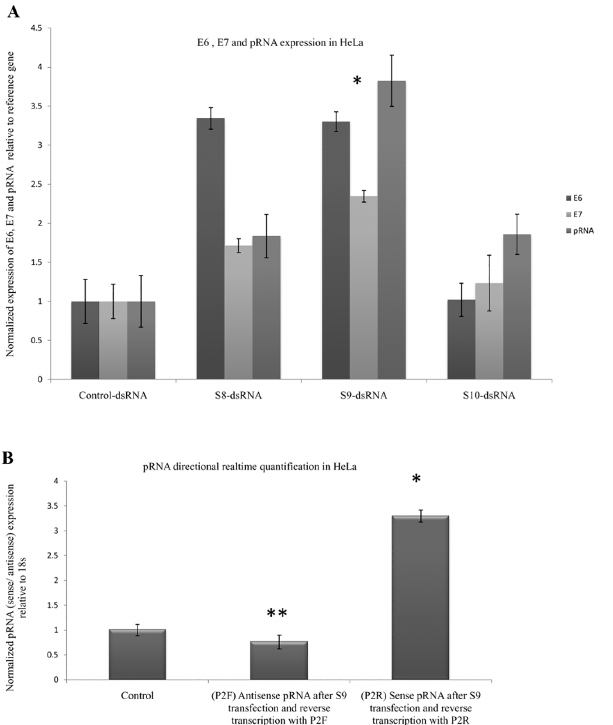
Fig 7. pRNA mediated gene activation. (A) Screening of three dsRNAs (100nM) targeting non-CpG sites in the pRNA of HPV18 in HeLa cells. RNA from the transfected cells was analyzed by Real time PCR 72 hours post transfection. Expression ratio was calculated with respect to 18S, POLR2A, PPIA and β -actin by REST software. S8-dsRNA: S8 dsRNA transfected cells, S9-dsRNA: S9 dsRNA transfected cells, S10-dsRNA: S10 dsRNA transfected cells. Control: Control dsRNA transfected cells. ( * ) P < 0.01, ( ** ) P = 0.03. (B) Change in bidirectional transcription after S9 dsRNA transfection. The levels of sense and antisense pRNAs were